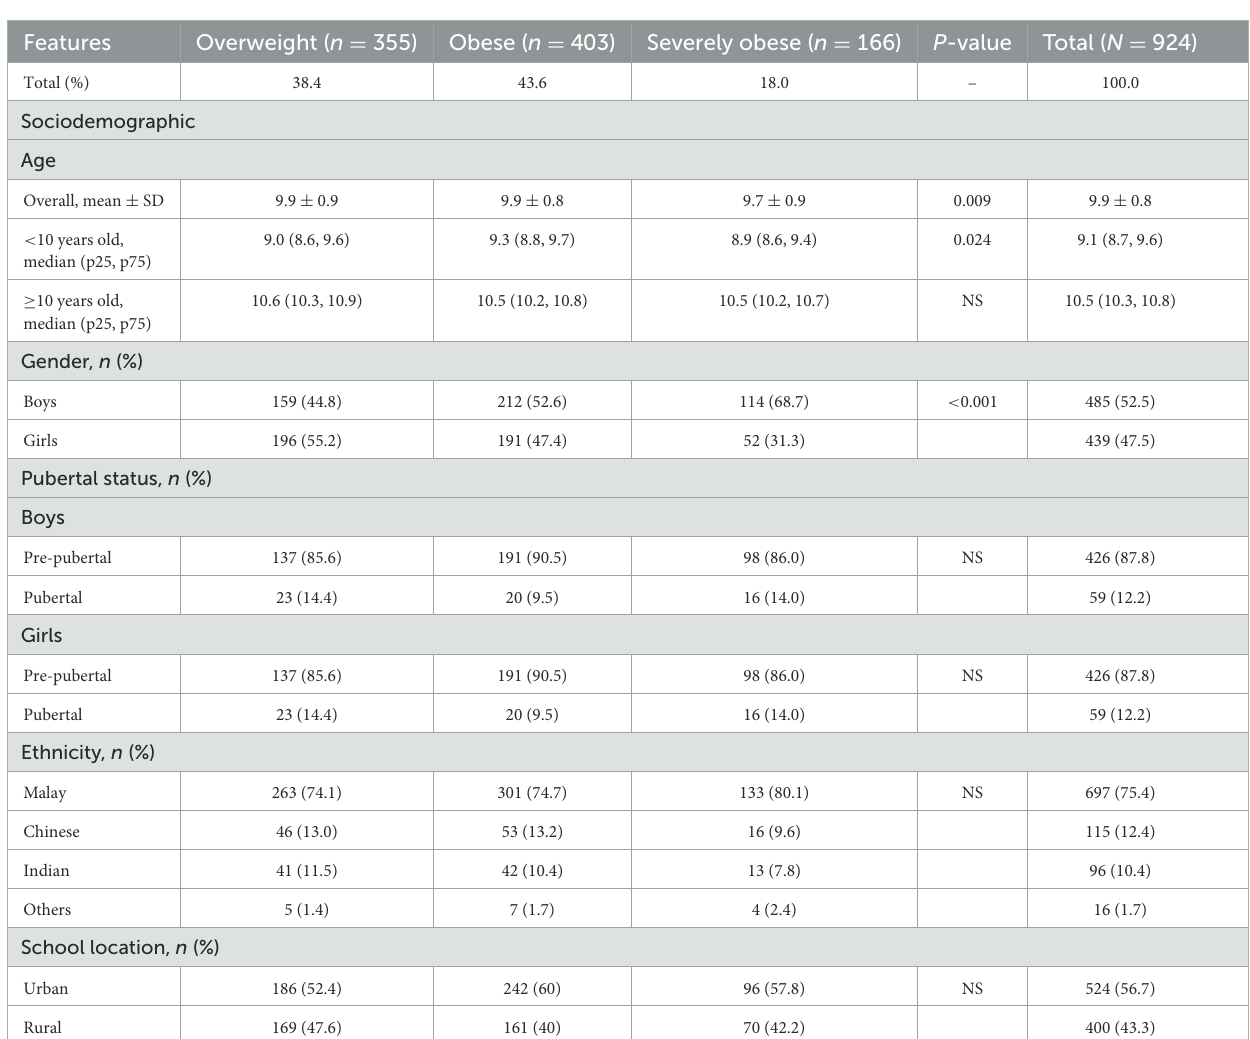
TABLE 1 Sociodemographic at baseline by obesity